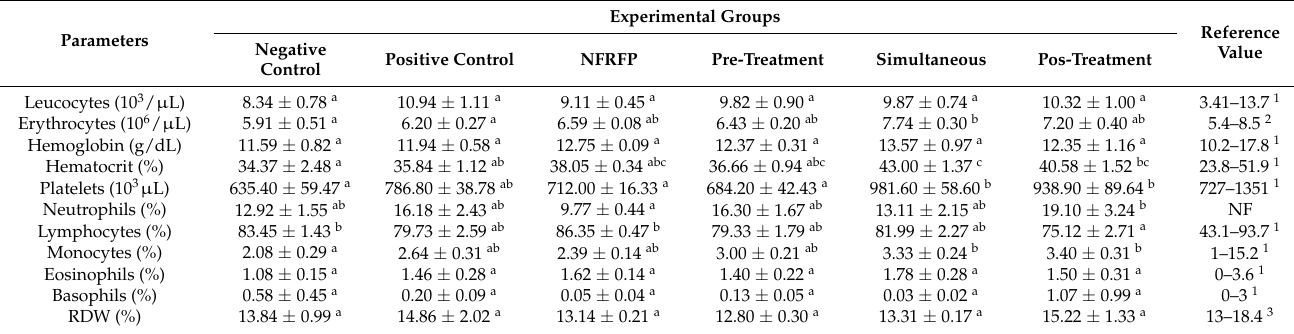
RDW: Red cell distribution width. NF—not found. Different letters on the same line indicate statistically significant differences. 1 Lima et al., 2014; 2 Lapchik, et al., 2009; 3 Melo et al., 2012. (Statistical test: ANOVA/Tukey p < 0.05).